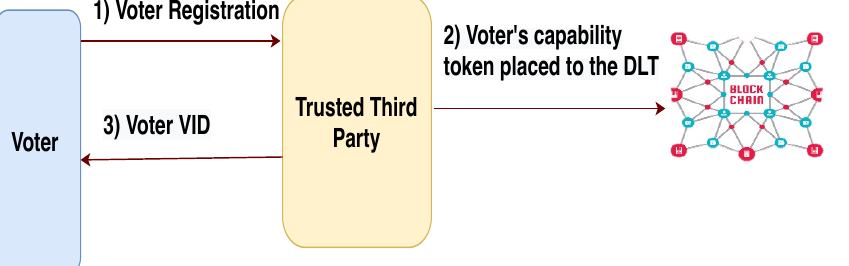
Figure 3. Voter experience during the registration phase: voters need to remotely register with the TTP prior to the election. The voter is given a unique pseudonyms key, which is used to provide authentication during voting.